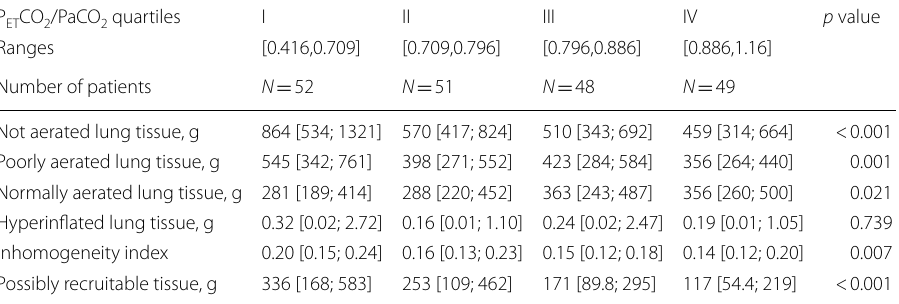
Data are expressed in medians and IQR. P for Mann–Whitney test